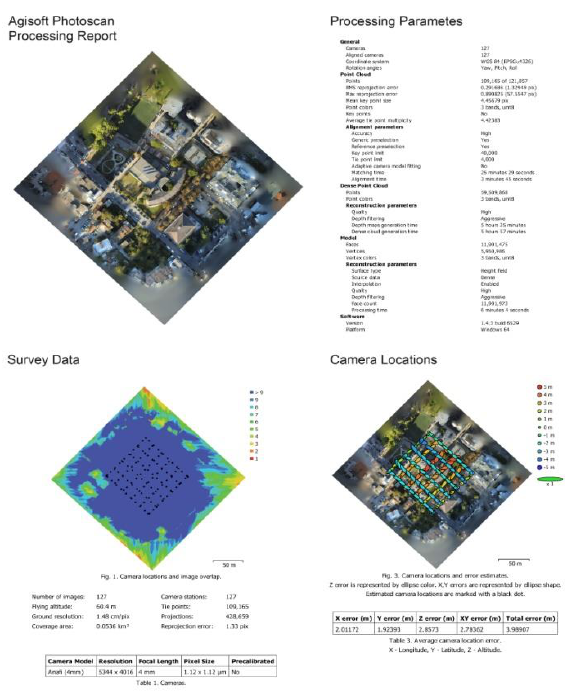
Figure 5. Agisoft Photoscan processing report of Borgomarino school. Survey data and camera